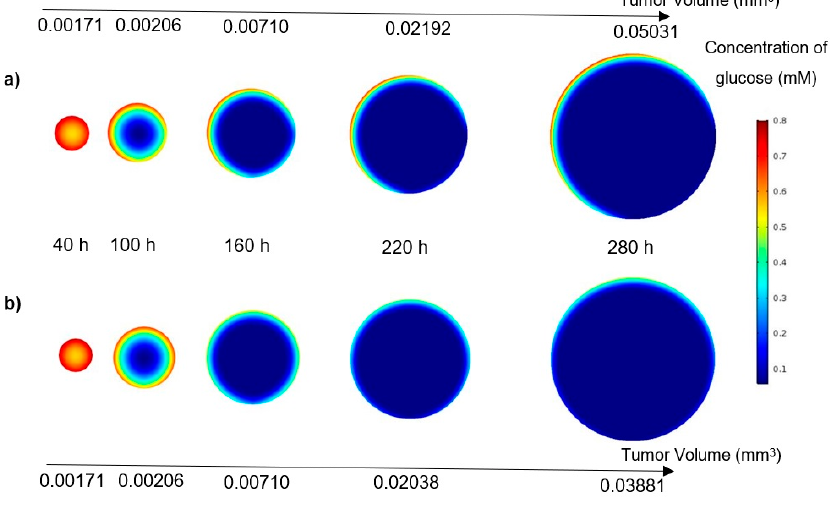
Figure 7. ( a ) Tumor volume; ( b ) Quiescent zone volume; ( c ) Necrotic zone volume for U-shaped barrier and microwell trap versus time (glucose and oxygen concentration at the inlet of each case are respectively 0.8 mM and 0.28 mM). The initial radius of the tumors in both of the traps is 24.3 μ m.